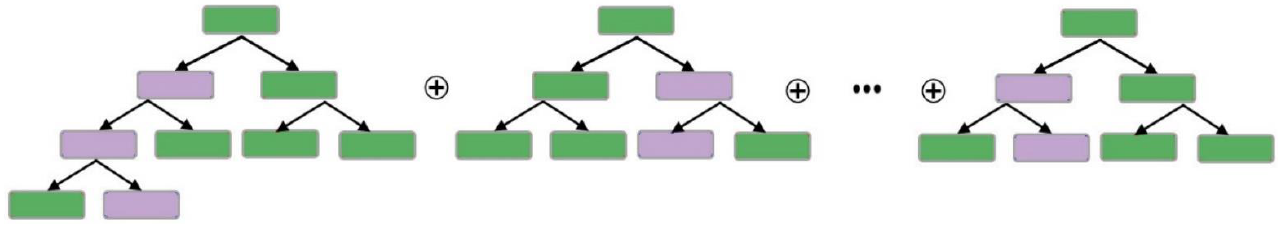
Figure 4. Schematic diagram of GBM classifier.